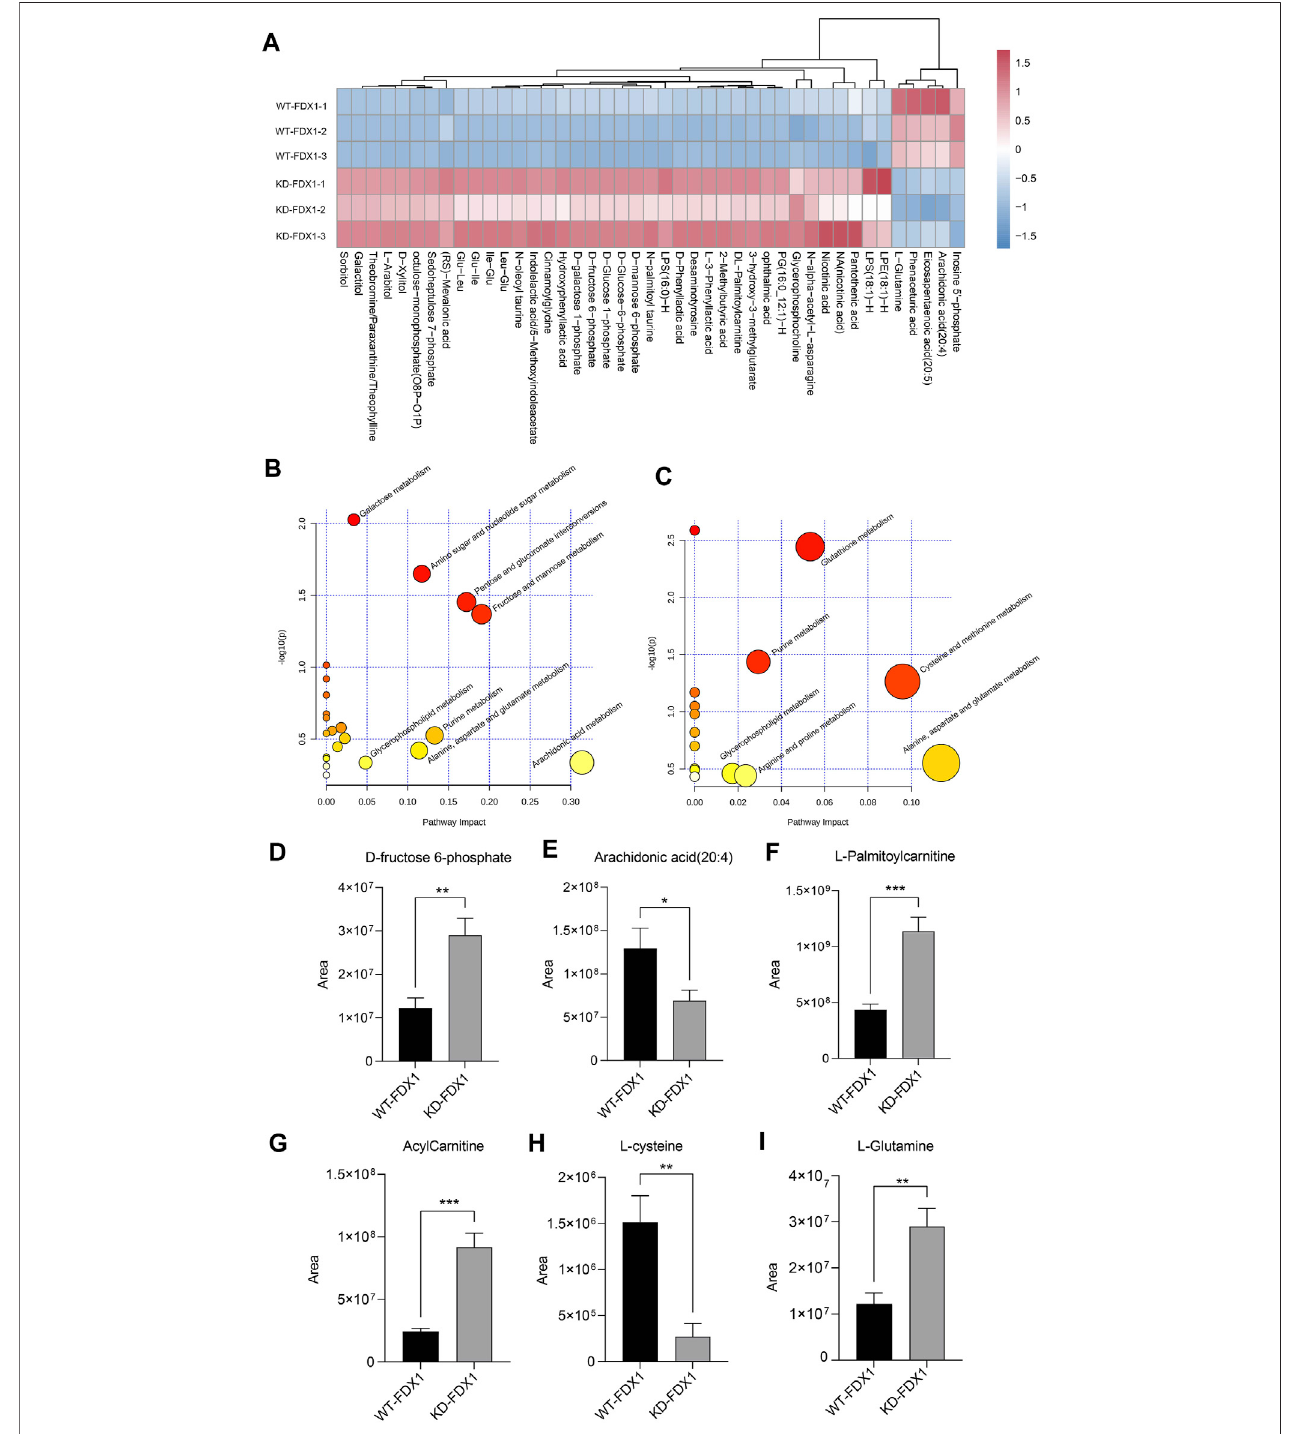
FIGURE6| Metabolicpro fi lingoftumorcellswithFDX1de fi ciency. (A) .TheheatmapofdifferentialmetabolitesinWT-FDX1andKD-FDX1cellsinthenegativeionmode. (B,C) .Pathwayenrichmentanalysisofthedifferentialmetabolitesinboththenegativeandpositiveionmodes. (D – I) .ThelevelsofD-fructose6-phosphate,arachidonicacid (20:4),L-palmitoylcarnitine,acylcarnitine,L-cysteine,andL-glutamineinWT-FDX1andKO-FDX1cells.Thedataarepresentedasthemean ± SD.* p < 0.01,** p < 0.001and *** p < 0.0001 ( t -test).